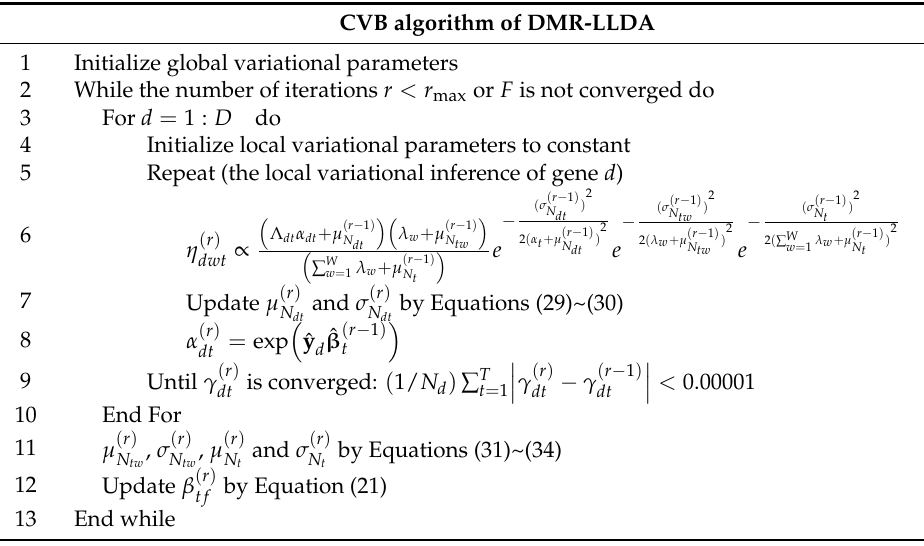
Table 1. Collapsed variable Bayesian (CVB) algorithm of DMR-LLDA.